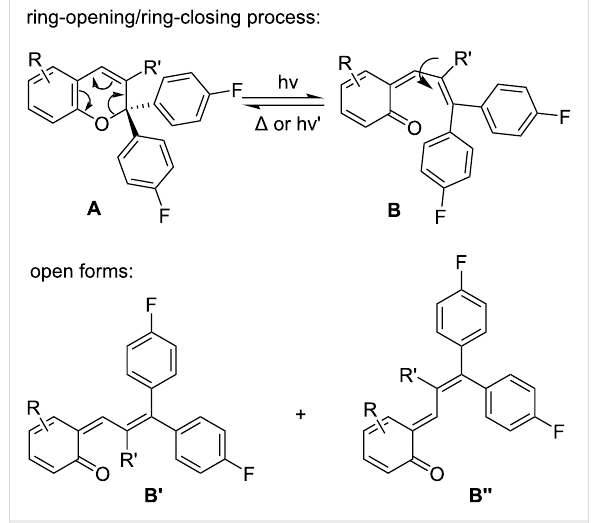
Scheme 1: Photochromism of 2 H